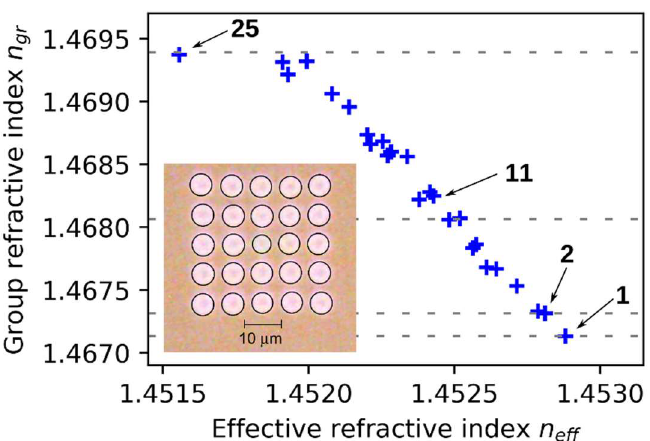
Figure 2. Numerically calculated (blue crosses) effective refractive indexes and group indexes of supermodes of the fabricated MCF. Group indexes of the 1st, 2nd, 11th, and 25th supermodes (grey dashed lines) measured in the experimental scheme shown in Figure 3. The numbers mark the 1st (in-phase), 2nd, 11th, and 25th (out-of-phase) supermodes shown in Figure 4. Experimentally measured (grey dashed lines) group indexes of the 1st, 2nd, 11th, and 25th supermodes. The inset shows the size and location of cores in the MCF used for modeling.